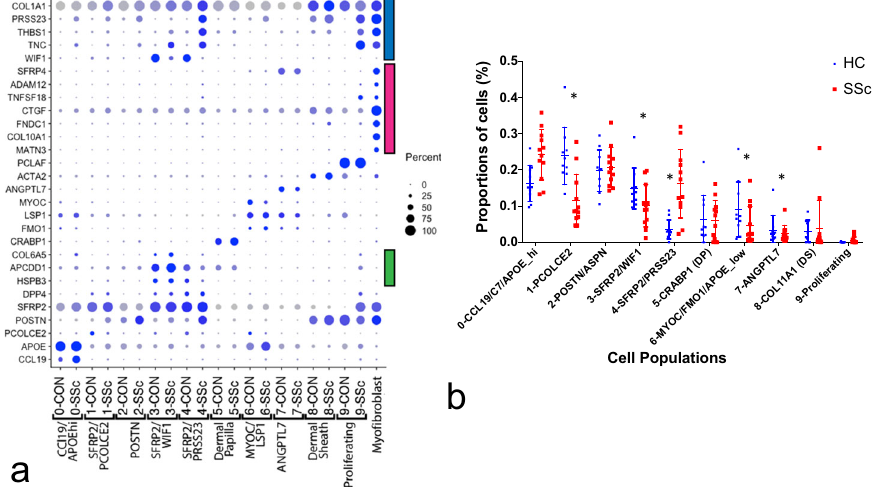
Fig. 3 Key marker genes and proportions of fi broblast subclusters from control healthy ( n = 10) and SSc ( n = 12) skin. Dot plots of gene expression markers of fi broblasts populations in healthy and SSc skin ( a ). Subpopulations of fi broblasts, including dermal sheath, dermal papilla, papillary (green bar), reticular and SSc fi broblasts (blue bar), and myo fi broblasts (red bar), are indicated. Proportions of fi broblast subclusters as from healthy control (HC, blue) numbered and SSc biopsies (red; clusters are numbered as in Fig. 2 ( b ). Cell populations are differentially expressed between the groups ( p < 0.001, chi square test), and clusters 1, 3, 4, 6, and 7 showed different proportions of cells comparing SSc and HC subjects ( p < 0.05, bars = mean and error bars = standard Expression of APOE de fi ned cells in two clusters: APOE hi / CCL19 / C7 -expressing fi broblasts (clusters 0), and APOE low / FMO1 / MYOC -expressing cells (subcluster 6, Figs. 2a and 3a). We have previously identi fi ed this latter population fi broblast population as distributed in interstitial and perivascular regions 27 .